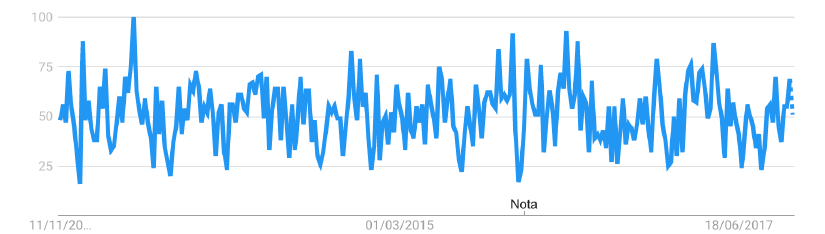
Fig. 5. World Interest along the time. User Innovation as a search term in https://trends.google.com for the last five years. 100% translates a peak of